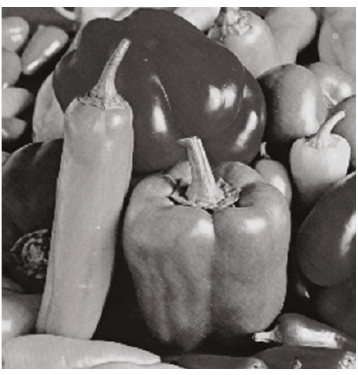
Figure 6: Original Image for analysis.